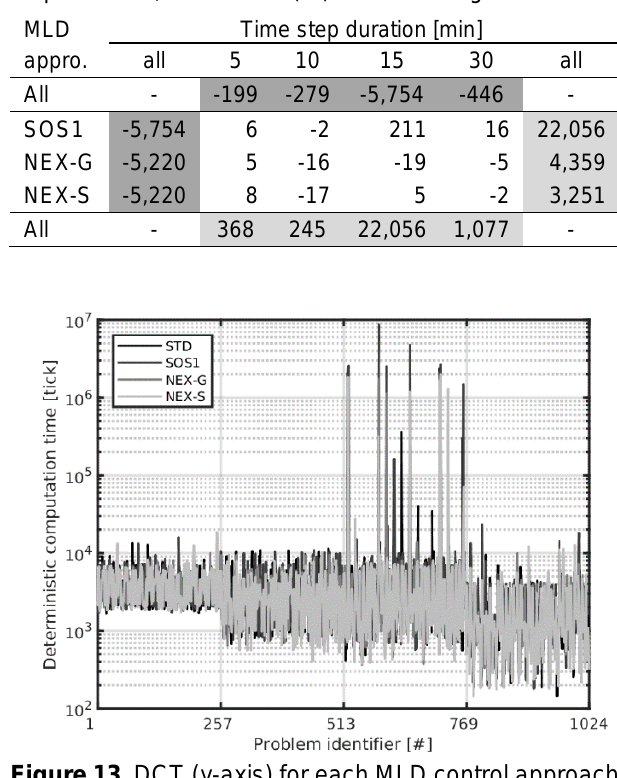
Table 8. Average, minimum (dark shade) and maximum (light shade) DCT differences for comparisons between non-STD and STD approaches, by approach and time step duration, as a share (%) of the average STD DCT.